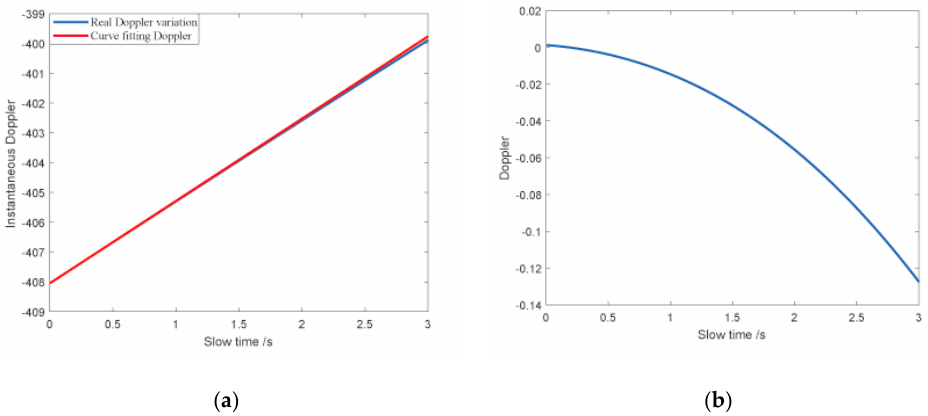
Figure 7. Doppler variation during the coherent processing interval (CPI). ( a ) Doppler variation and curve fitting result. ( b ) Curve fitting error.